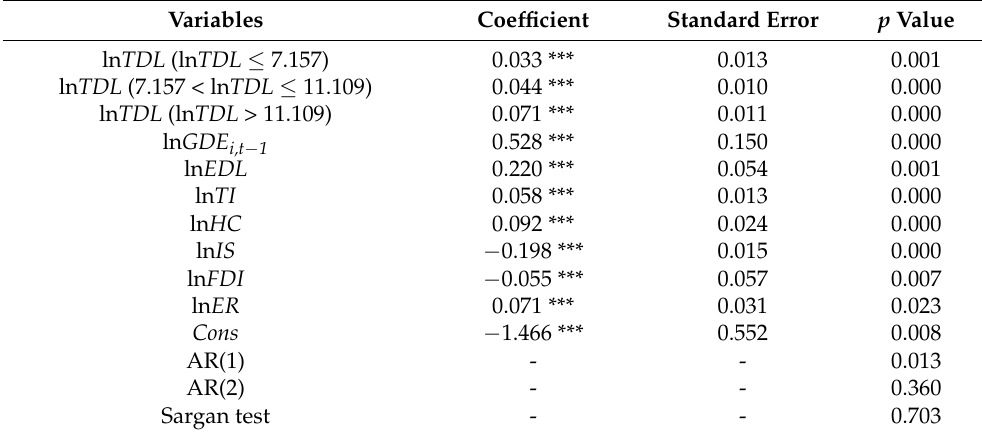
Table 6. Estimation results of dynamic panel threshold regression